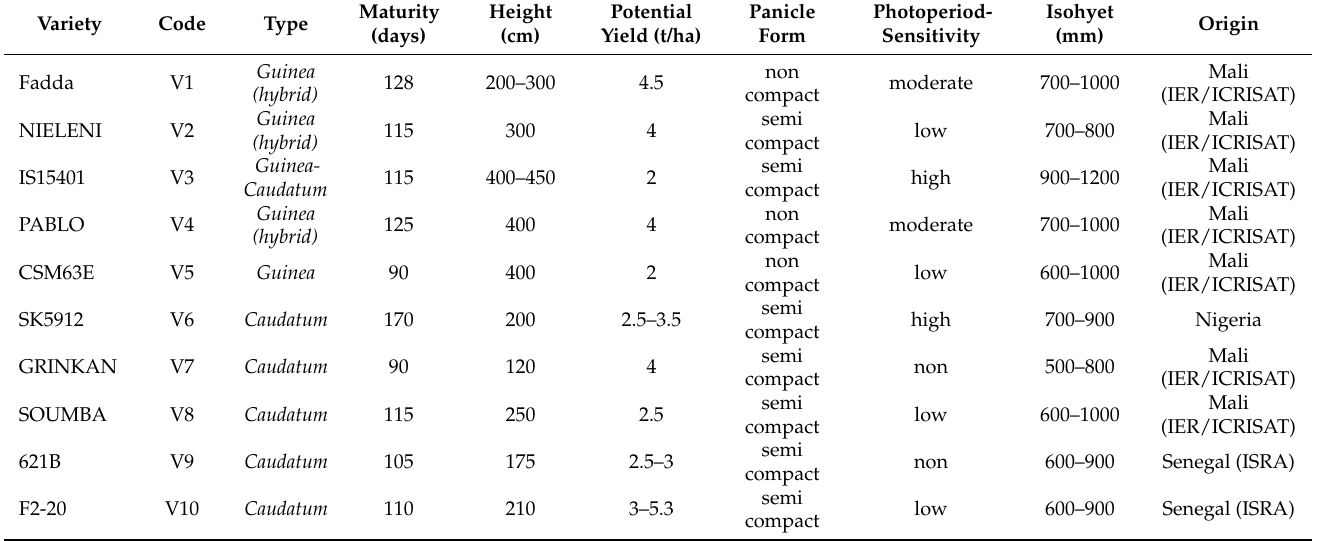
Table 1. Characteristics of the varieties used in this study and their